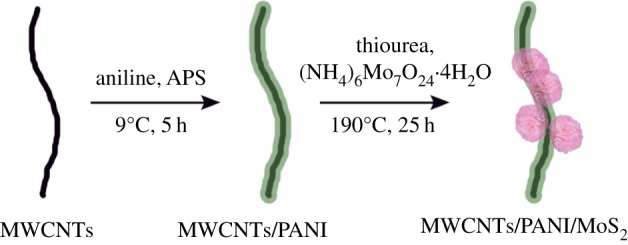
Schematic illustration for synthesis of MWCNTs/PANI/MoS2 ternary nanocomposites.